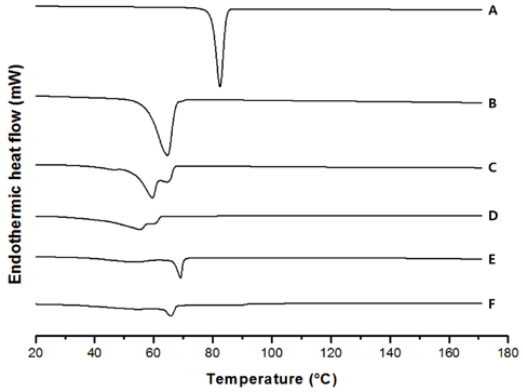
Figure 5. DSC thermograms of ( A ) PR only; ( B ) GMS; ( C ) lipid melt; ( D ) PR-lipid melt; ( E ) freeze-dried blank-NLCs; ( F ) freeze-dried PR-NLCs.